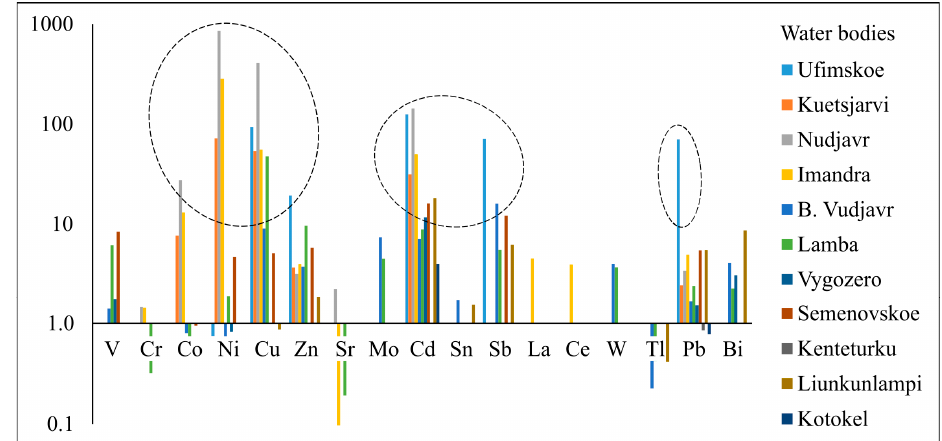
Figure 19. Enrichment factors of chemical elements from lake sediments described in this review (Figure 1).